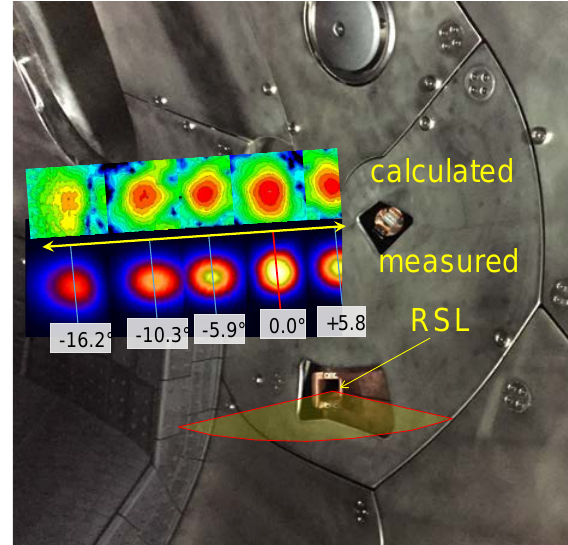
Fig1: Remote steering antenna mouth in the plasma vessel. Comparison of measured and calculated beam pattern for different launch